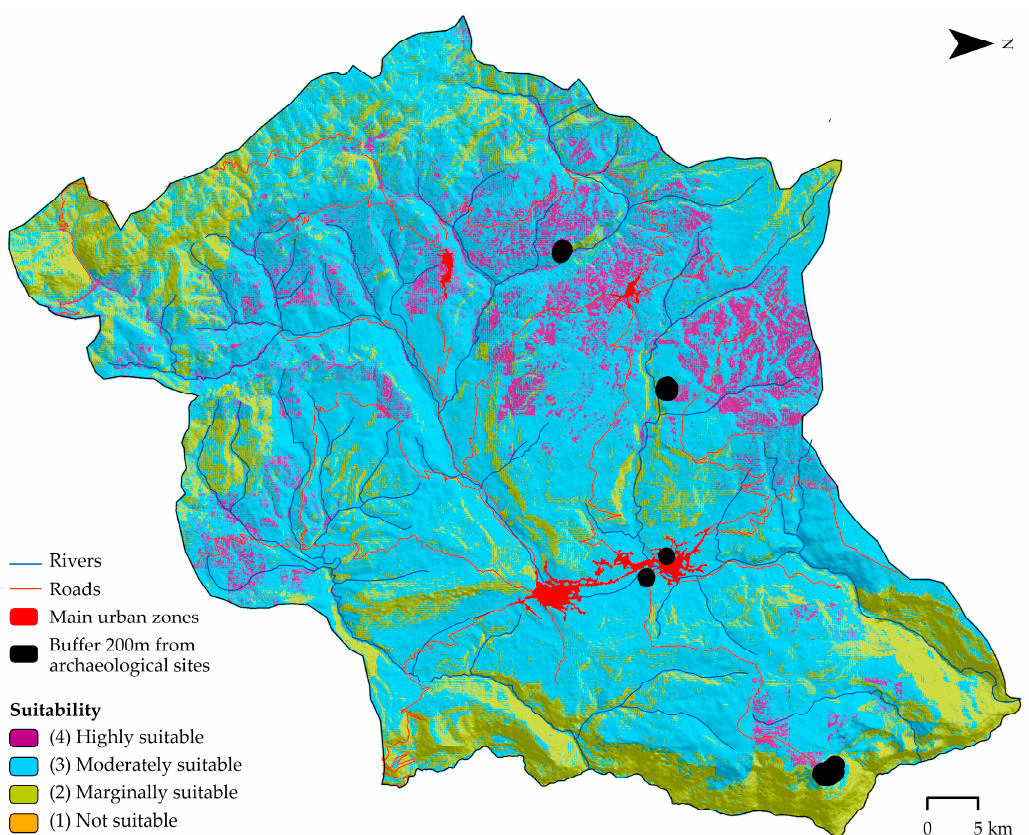
Figure 7. Land Suitability Map for potato cultivation in the Jucusbamba and Tincas microwatersheds, Amazonas (NW Peru).